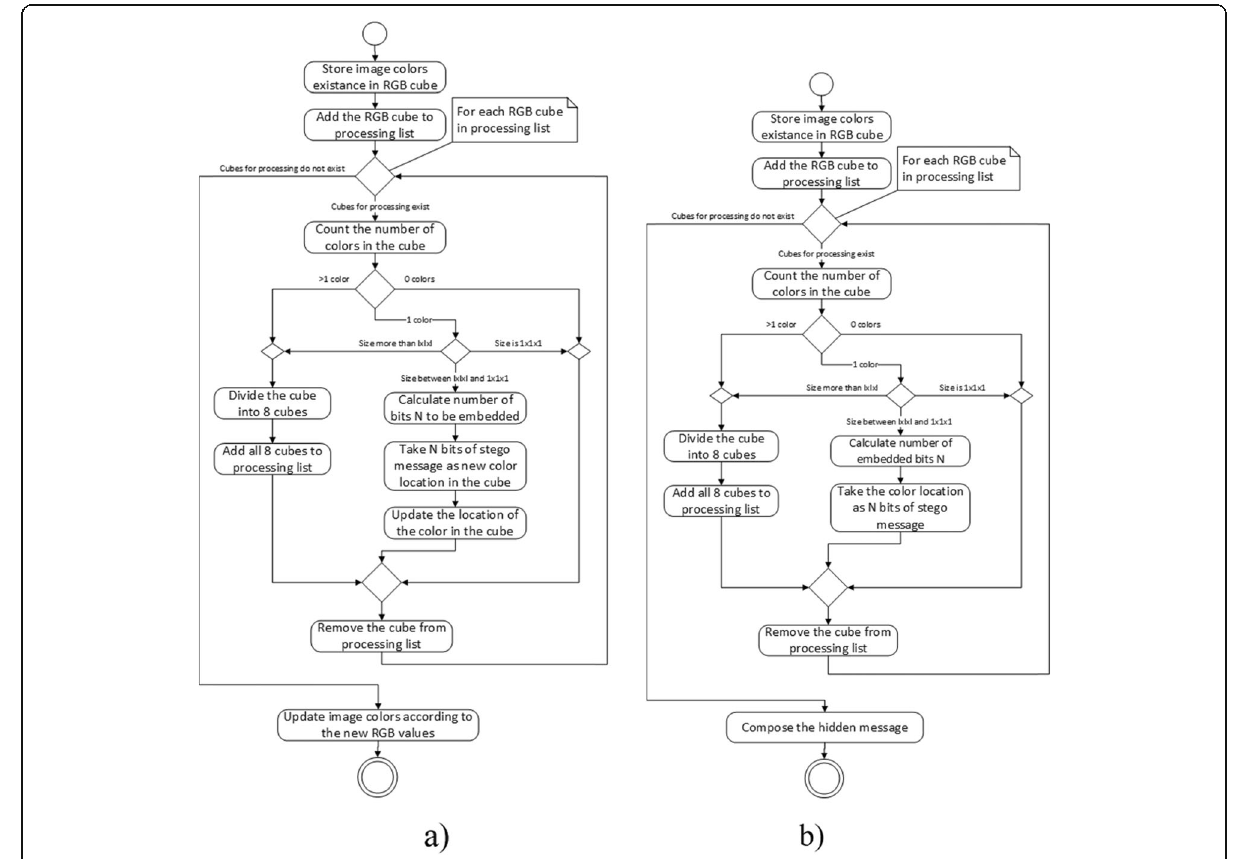
Fig. 4 Stegomessage embedding ( a ) and stegomessage retrieving ( b ) algorithms of the proposed